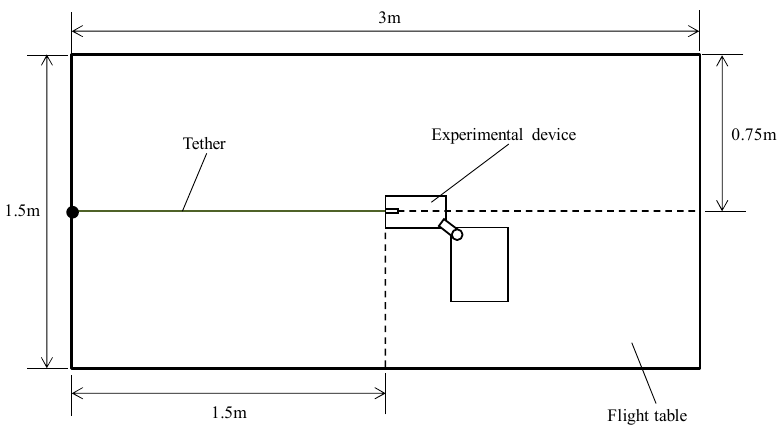
Figure 8. Schematic of experimental setup.